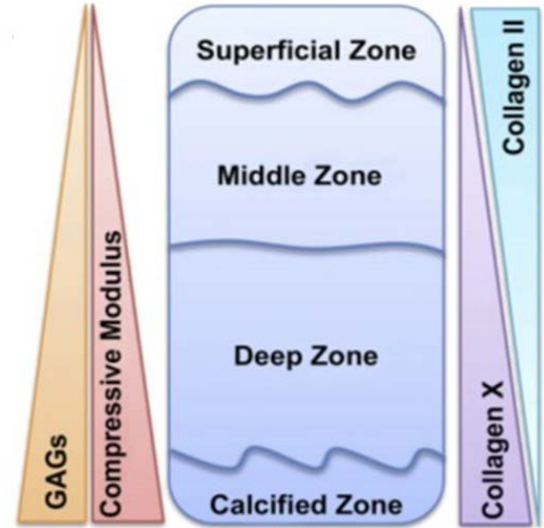
Figure 4. Schematic of articular cartilage anatomy which illustrates how the GAG content, collagen X and compressive modulus increase from the superficial to the deep zones of articular cartilage. Collagen II is also shown too decrease in content from the superficial to the deep zones of articular cartilage. Adapted with permission from ref [41]. Copyright 2011 by Elsevier, Inc.